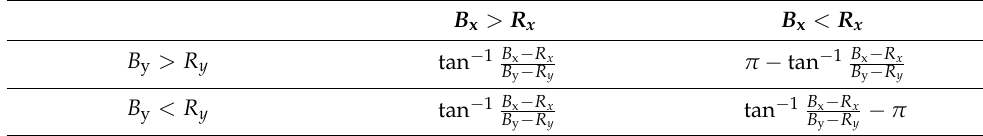
Figure 6. Relative relationship between fingers. The blue dot represents the thumb and the red one represents the index finger. Table 2. Finger angle conversion table.